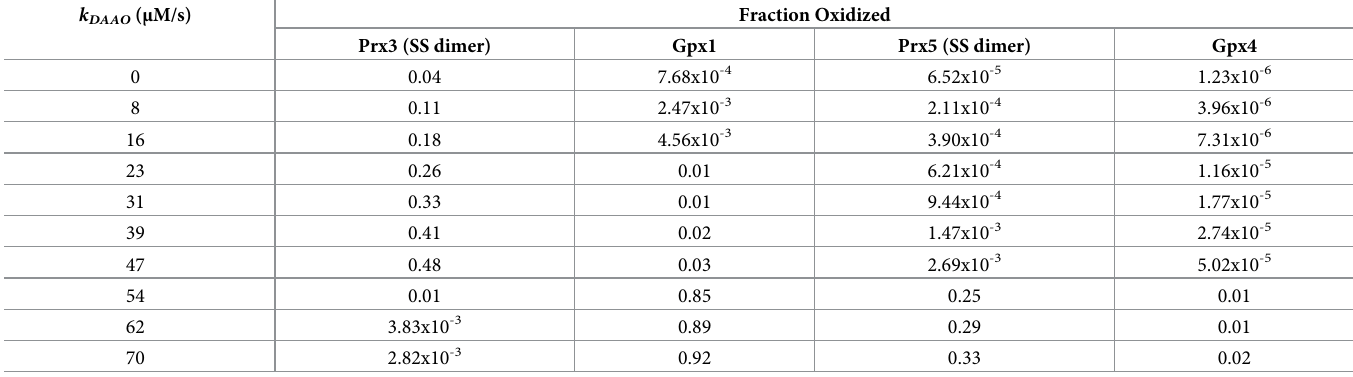
Table 5. Summary of fractional oxidation with changing H 2 O 2 perturbations for the major antioxidants in the network at 1 hr with an initial Prx3-SH concentra- tion of 62 μ M. k DAAO ( μ